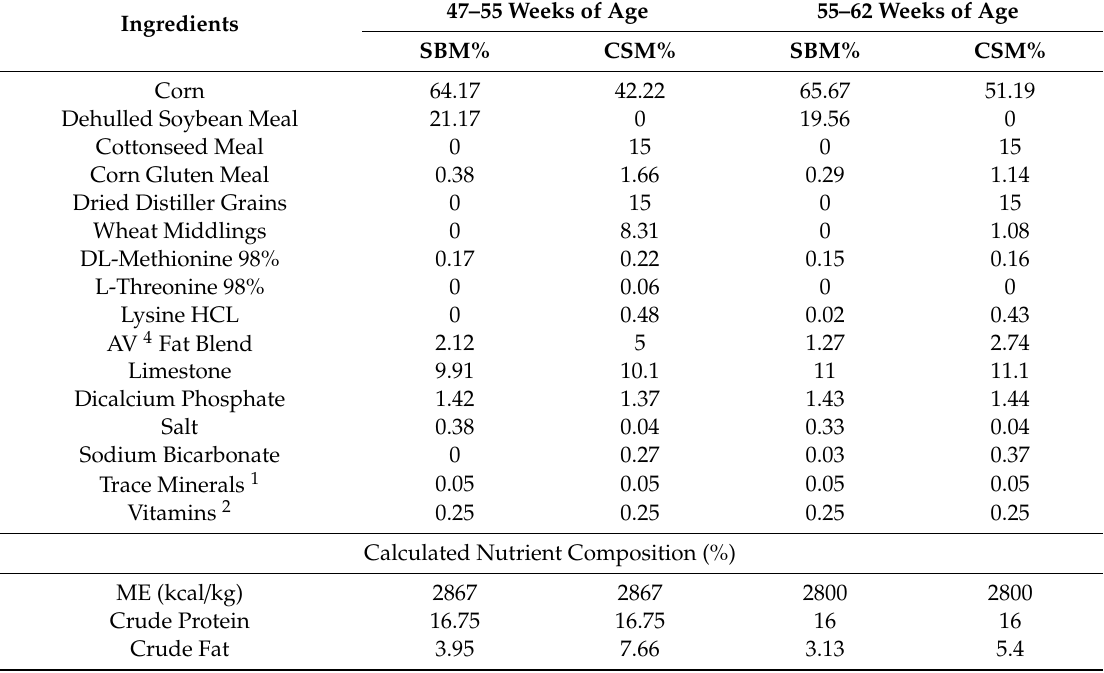
Table 1. Composition and nutrient levels of soybean meal (SBM) and cottonseed meal (CSM)